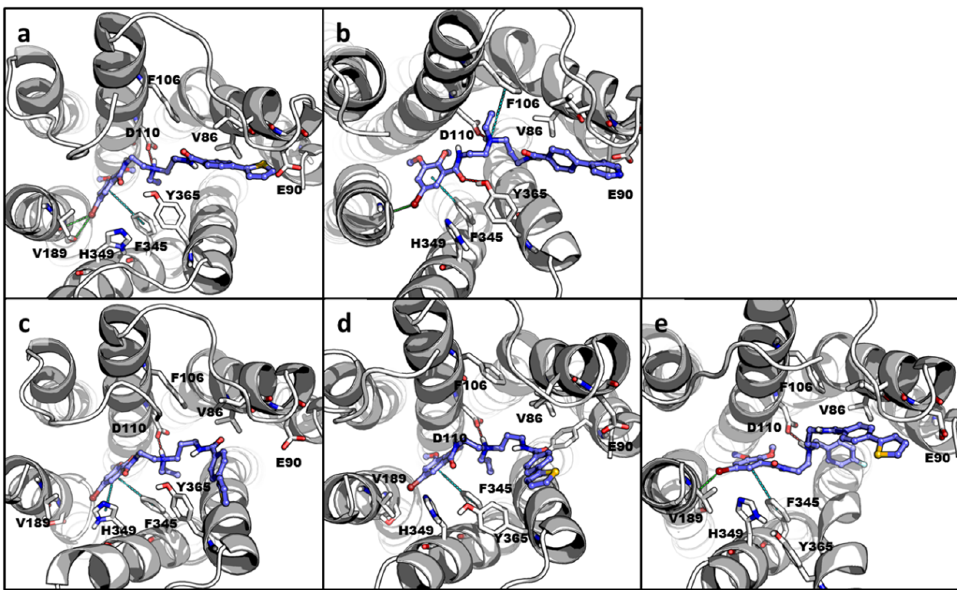
Figure 1. Representative poses of MDS for ( a ) 9a , ( b ) 21c , ( c ) 20a , ( d ) 20b , and ( e ) 20c . The predicted interactions of each compound with residues in the OBS and the SBS of the D 3 receptor were distinguished by the color. Red: hydrogen; cyan: π -interactions; green: halogen bond.